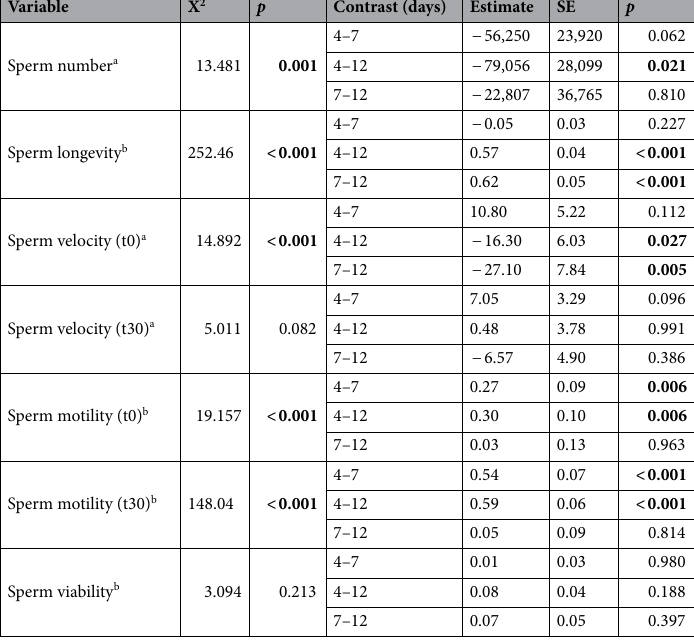
Fig. 2g). Results from the post-hoc tests among the different sperm storage duration (shown in Table 1) revealed that sperm collected from the longest sperm storage (12 days) were significantly faster (Fig. 2c) but lived shorter than sperm from males with 4 or 7 days of sperm storage (Fig. 2b). The proportion of motile sperm was instead highest in sperm from males after 4 days of sperm storage both immediately after activation and after 30 s (Fig. 2e,f).